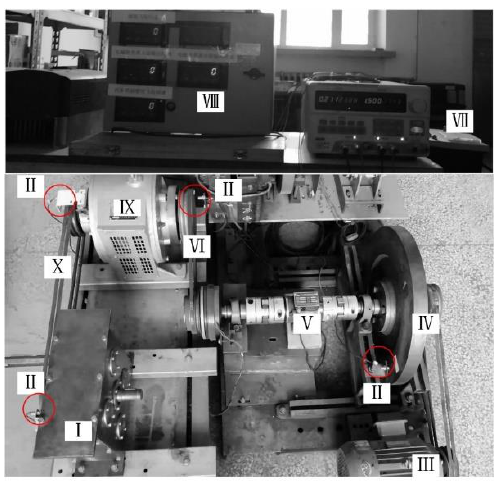
Figure 10. ECFESS test bench. I — flywheel I; II — speed sensor (red circle); III — motor; IV — flywheel II; V — torque sensor; VI — first-stage V-belt; VII — controller; VIII — data collection system; IX — electromagnetic coupler; X — second-stage V-belt. Table 4. Experimental parameters of the ECFESS.